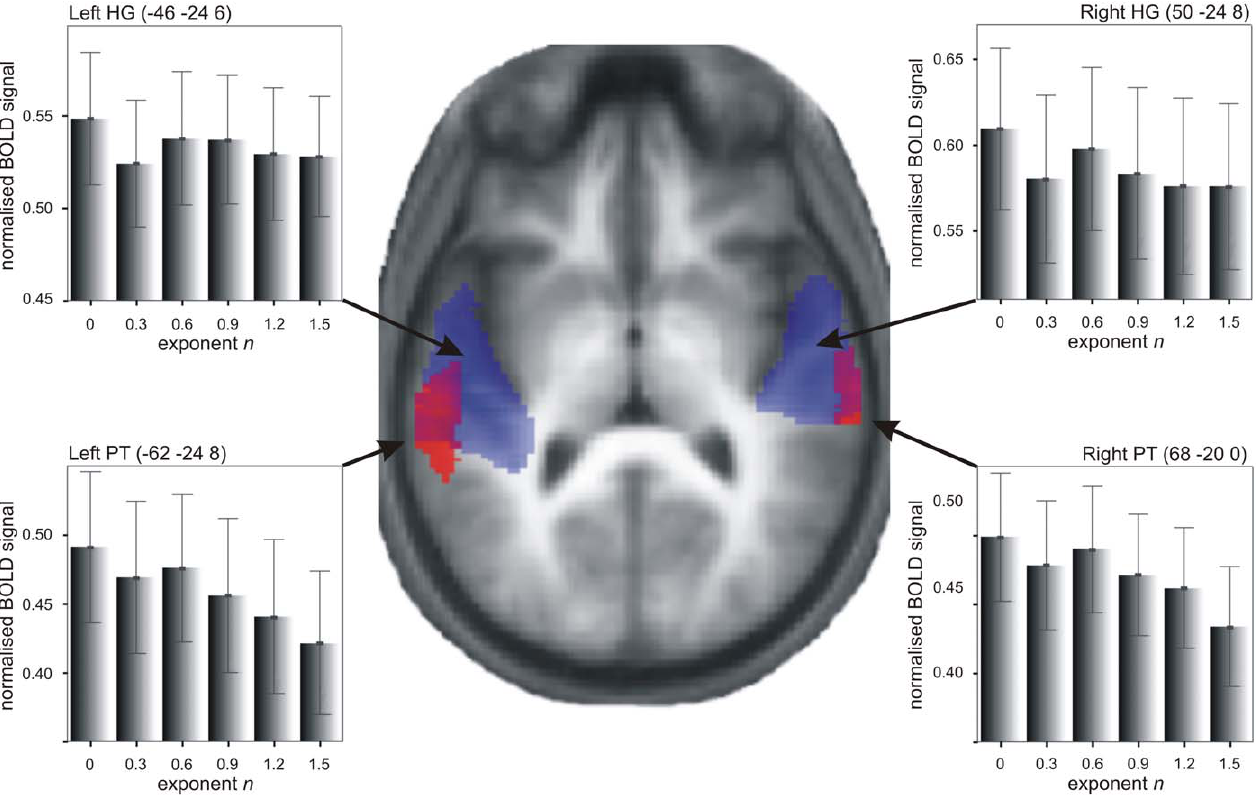
Figure 2. Study 1 Functional Imaging Data: Effect of Entropy Areas showing an increase in BOLD signal ( p , 0.001, uncorrected for multiple comparisons across the brain) as a function of increasing entropy (red) and areas that responded to sound in general ([sound–silence] contrast, p , 0.05, FWE corrected) (blue) rendered on a tilted (pitch: (cid:2) 0.4) axial section of participants’ normalised average structural scan. Normalised mean percent BOLD signal change ( 6 SEM) at the local maxima in the left and right PT (bottom) and HG (top) is plotted for the six levels of exponent n .